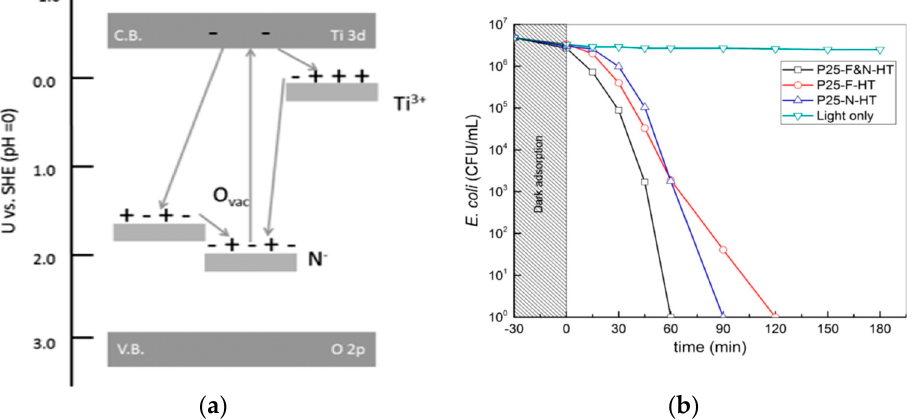
Figure 26. ( a ) Visible light excitation of N − F codoped TiO 2 and subsequent filling of empty N state by electron transfer from either Ti 3+ or oxygen vacancies (O vac ) . Reproduced with permission from [268]. Copyright American Chemical Society, 2014. ( b ) Survival rate of E. coli treated with N-doped P25 (P25-N-HT), F-doped P25 (P25-F-HT) and (3) F-N codoped P25 (P25-F&N-HT) under simulated light illumination. Reproduced with permission from [270]. Copyright MDPI, 2017.